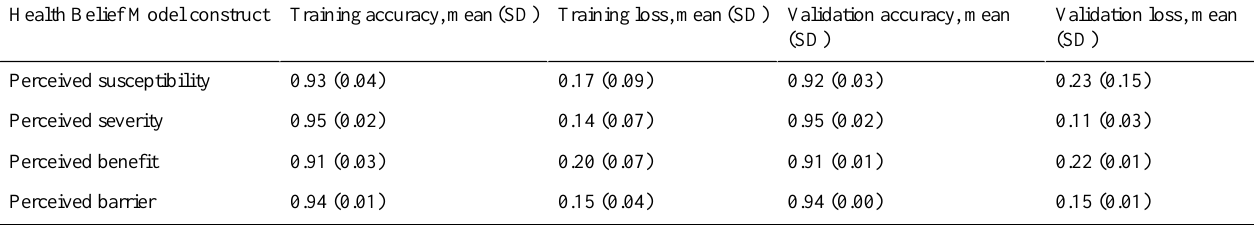
Table 2. Health Belief Model classification models’performance